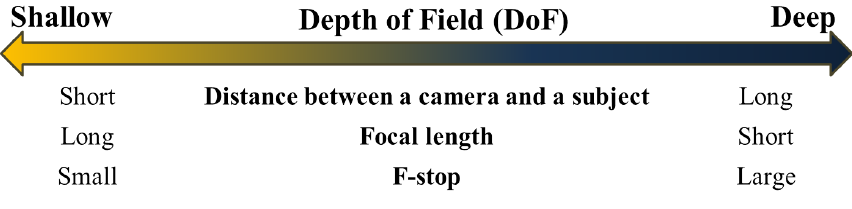
Figure 1. Factors for the adjustment of the depth of field